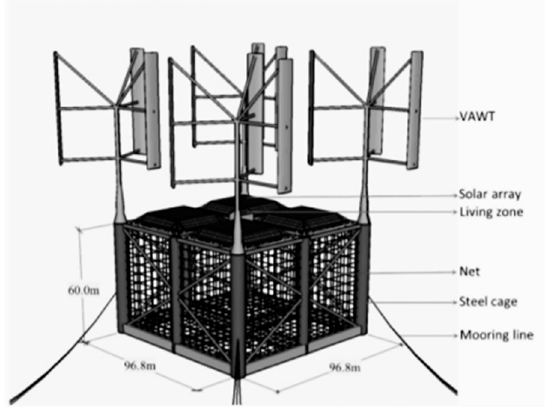
Figure 9. Multi-purpose platform combining offshore floating photovoltaic, wind turbine, and aq- uaculture [39]. Reprinted with permission from Ref. [An offshore floating wind–solar–aquaculture system: Concept design and extreme response in survival conditions]. 2020, Zheng, X.